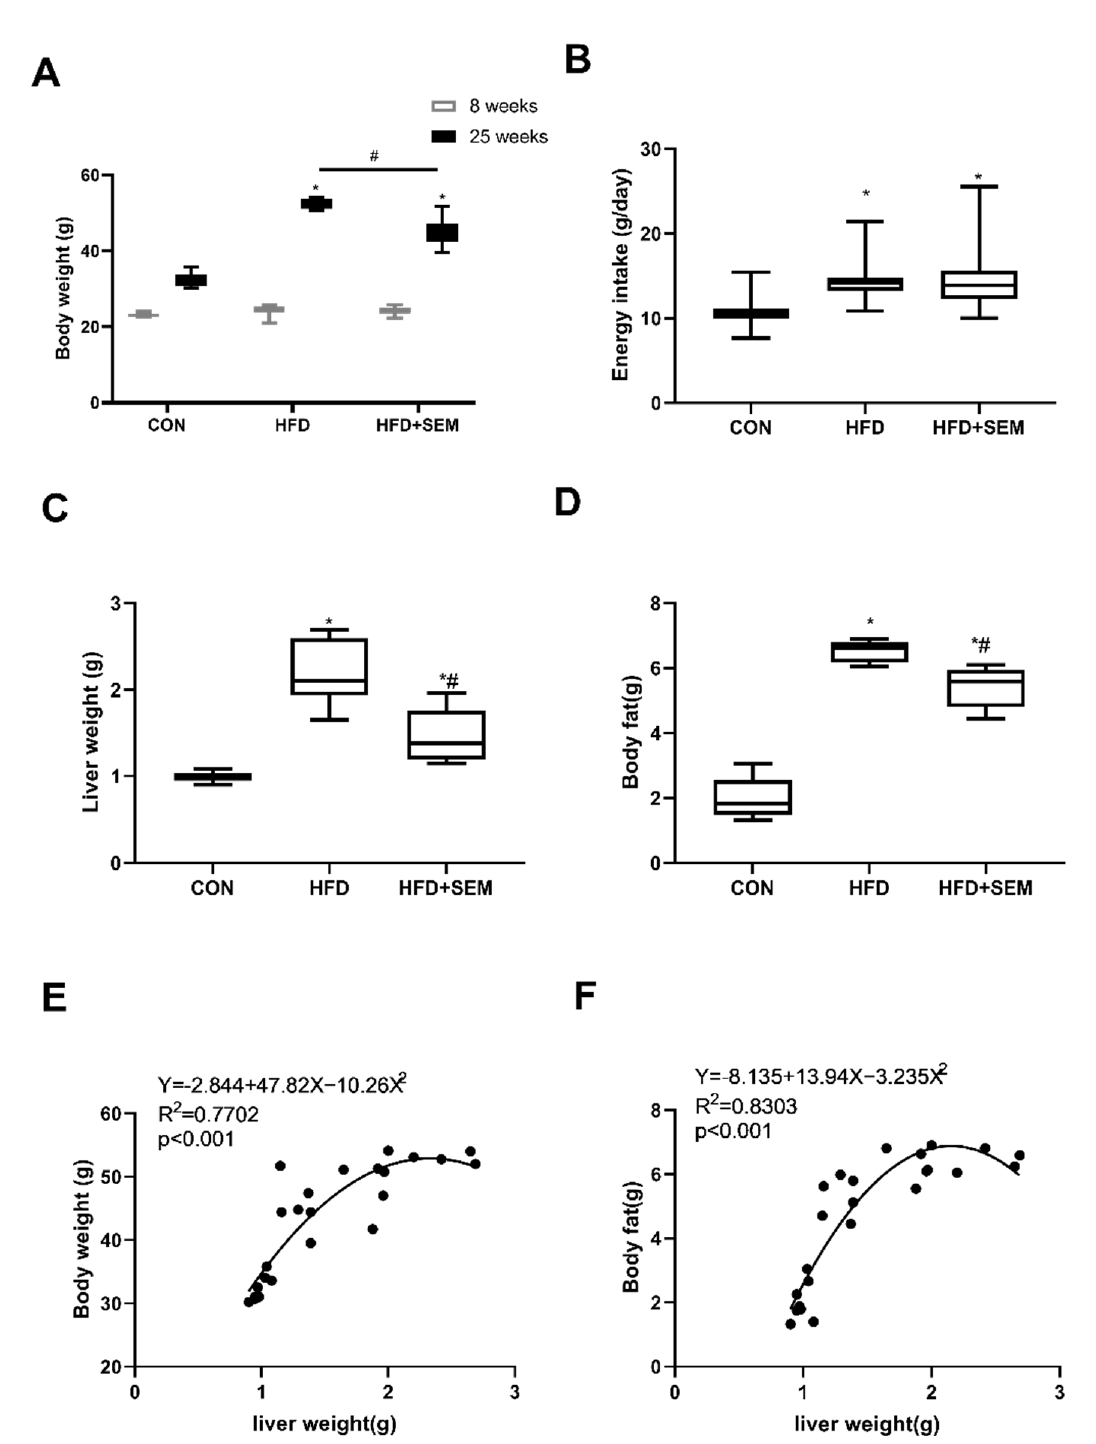
Figure 1. Sesamol (SEM) improves hepatic steatosis in high-fat diet (HFD)-fed mice. Effects of HFD and HFD + SEM on ( A ) body weight, ( B ) energy intake, ( C ) liver weight, ( D ) body fat, ( E ) correlation of body weight with liver weight, and ( F ) of body fat versus with weight. Box-and-whisker diagrams are presented as min to max and analyzed with one-way ANOVA; * marks significant differences compared to the control group ( p ≤ 0.05); # marks significant differences between the HFD group and the HFD + SEM group ( p ≤ 0.05). Correlation data ( E , F ) were fitted to a second-order polynomial. Equation, r 2 and p -value are shown in the left upper corner. Statistical analysis was performed by the Spearman’s rank correlation test; p ≤ 0.05 shows a statistically significant relation. 3.2. Markers of Oxidative Stress in Serum As shown in Figure 2A, the levels of MDA in serum samples were significantly in- creased in the HFD group compared with the CON group. Interestingly, the administra- tion of SEM markedly reduced the MDA serum levels, which indicated that the HFD- induced systematic oxidative stress was improved after SEM treatment. In addition, liver weight was positively correlated with serum MDA levels (Figure 2C), suggesting serum MDA was associated with hepatic steatosis. However, serum SOD levels were not signif- icantly changed by the interventions (Figure 2B).